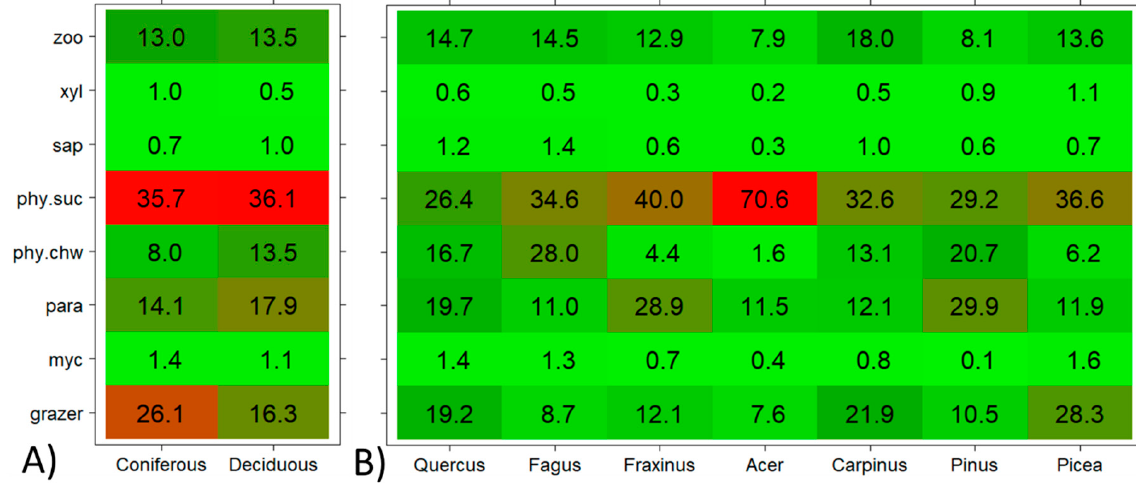
Figure 4. Relative proportions of beetles per feeding guild on deciduous and coniferous trees ( Picea and Pinus ( A )) and on tree genera ( B ). The darker the shade of green, the greater the proportion of the particular guild; the highest values are shown in bright red. We used only tree genera with at least 10 fogged trees in the analyses. The total number of foggings was 319.